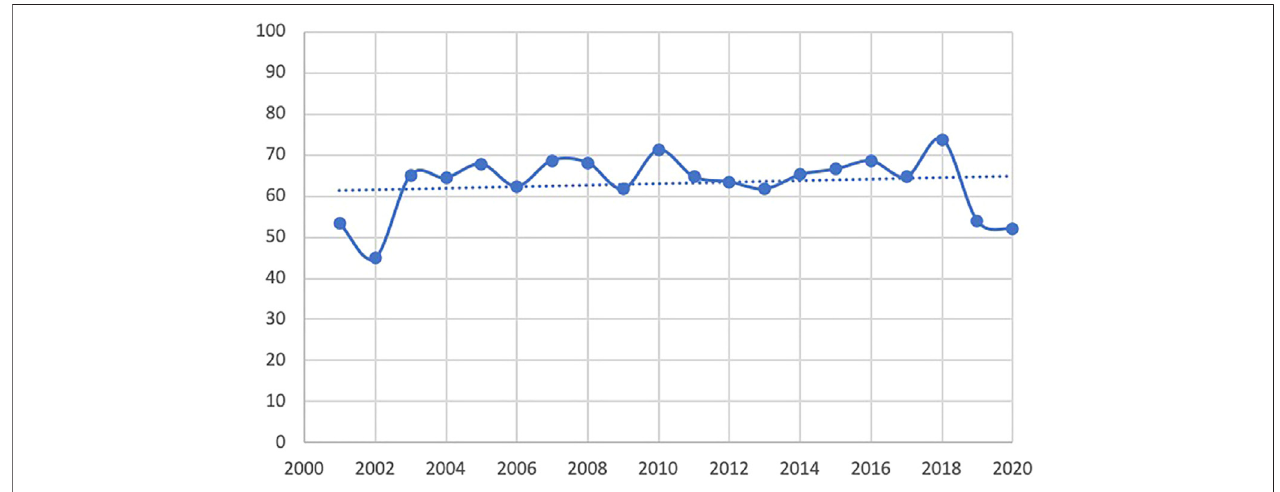
FIGURE 4 | QHES scores by published year. QHES, Quality of Health Economic